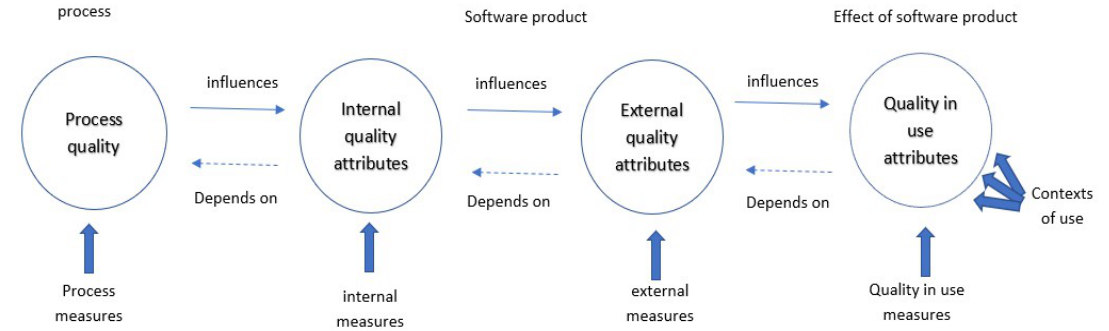
Figure 1. ISO/IEC 2501-3/2009: internal and external quality games aspects.